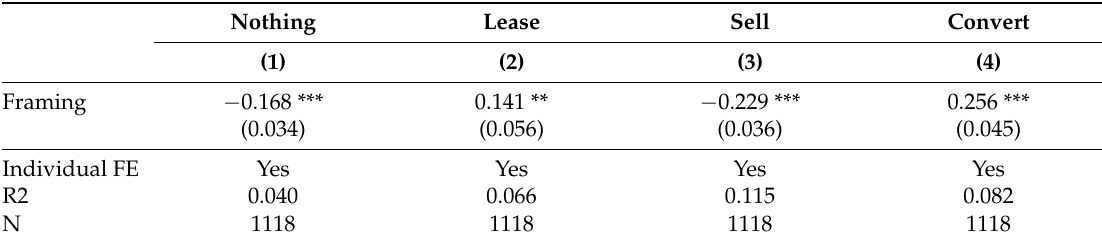
Table 3. Effects of framing on experimental choices.